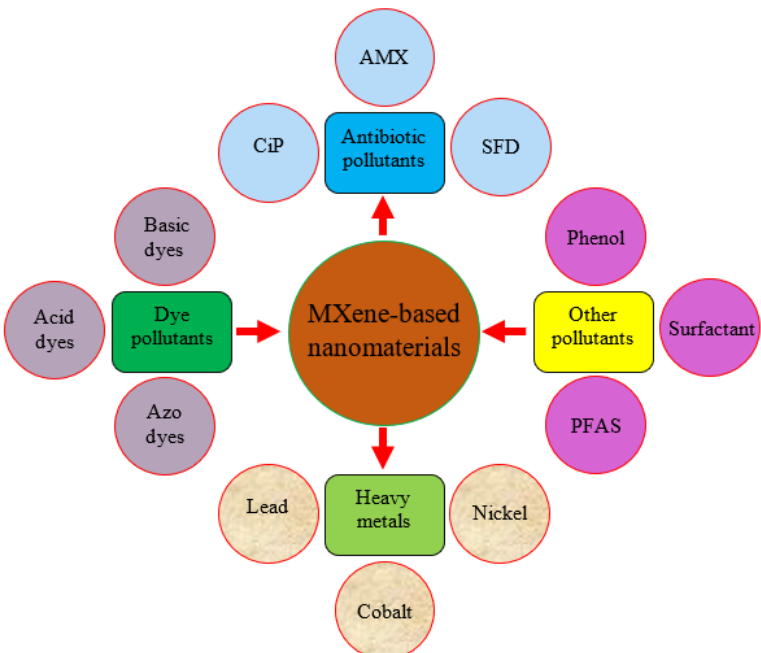
Figure 11. Applications of MXene-based nanomaterials for the remediation of different pollutants from